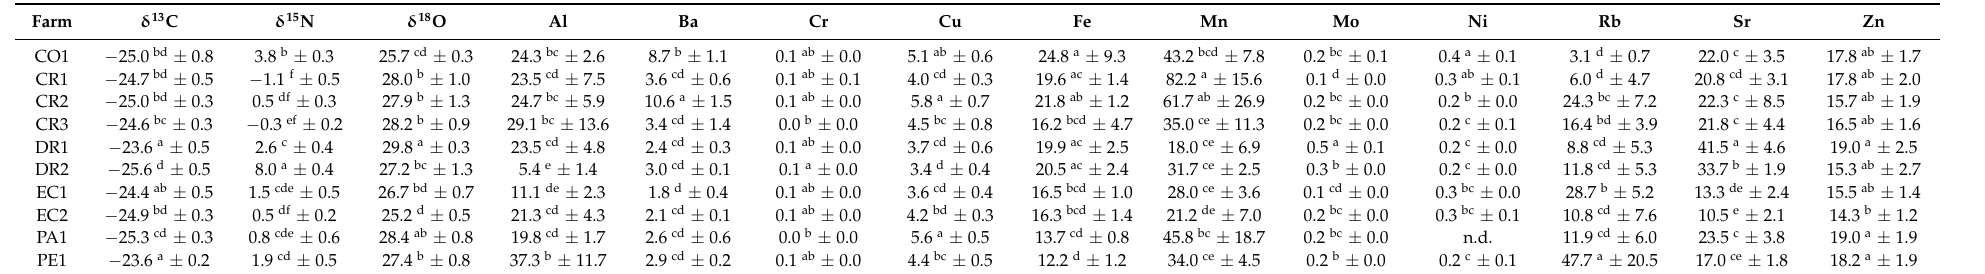
Table 3. The analysis of variance (ANOVA) of stable isotopes ratios ( 13 C/ 12 C, 15 N/ 14 N and 18 O/ 16 O) and elemental compositions (mg/kg) of banana peel samples ( n =